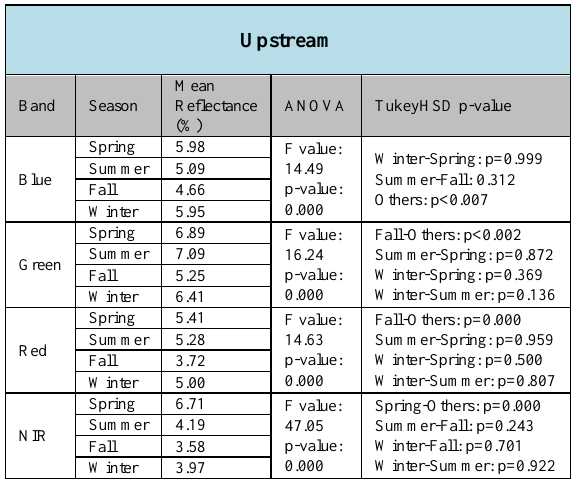
Table 3. Effect of seasonal factor on band reflectance The effect of seasonal factor on band reflectance is summarized in Table 3. The low p-values of the ANOVA analysis results indicate that the band reflectances are associated with the seasons very significantly. In the case of upstream, fall is significantly different in the green and red bands, while spring is significantly different in the NIR band. Winter and spring reflectances are quite identical in the blue band. In the case of mid-stream, fall reflectances are different in the blue band. Spring and summer reflectances are similar in the green and red bands. NIR reflectances are particularly high during the spring season. In the downstream, spring reflectances are significantly high in the four bands and summer and fall are similar in most